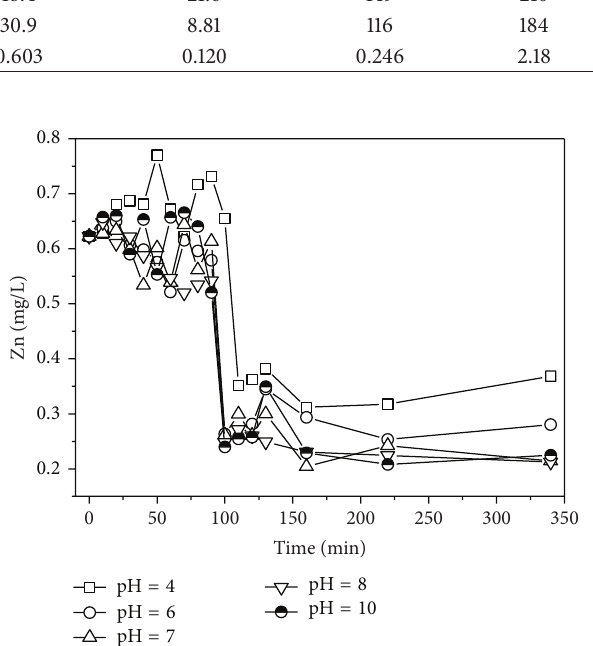
Figure 1: The concentration of Zn in the overlying water changed with times.